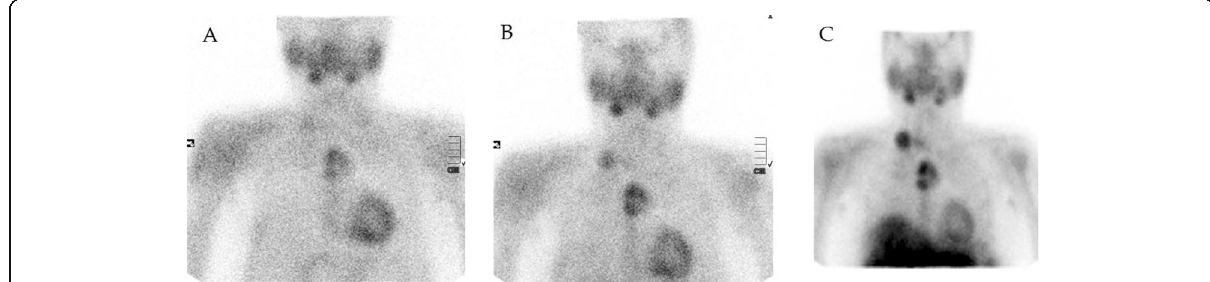
Fig. 2 99m Tc MIBI scan images: A 20-min, B 1-h, and C 2-h images showing increased accumulation of Tc-99m MIBI uptake in the right supraclavicular and superior mediastinal